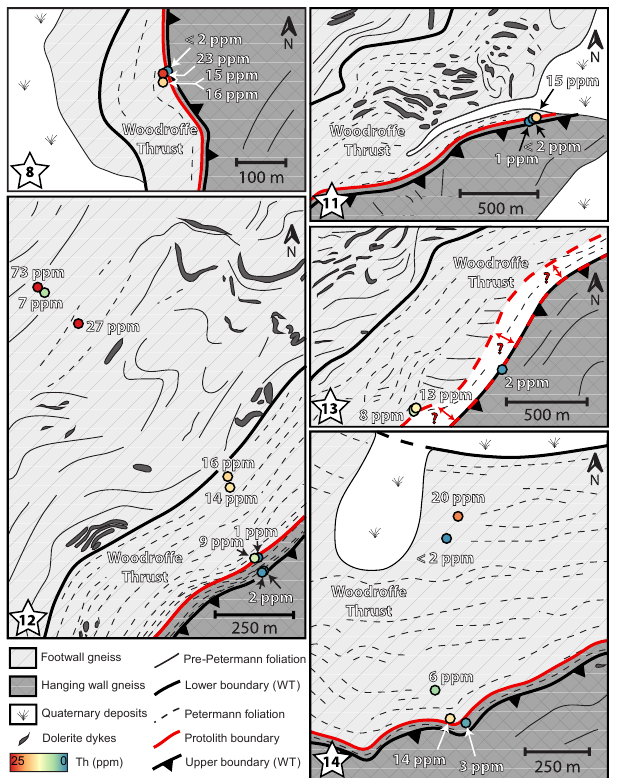
Figure 6. Sample-specific thorium (Th) concentrations (measured by γ -ray spectrometry) plotted across the Woodroffe Thrust (WT) mylonites at locations 8 and 11–14 (Fig. 1). The original boundary between the lower-thorium hanging wall and higher-thorium foot- wall is inferred (red